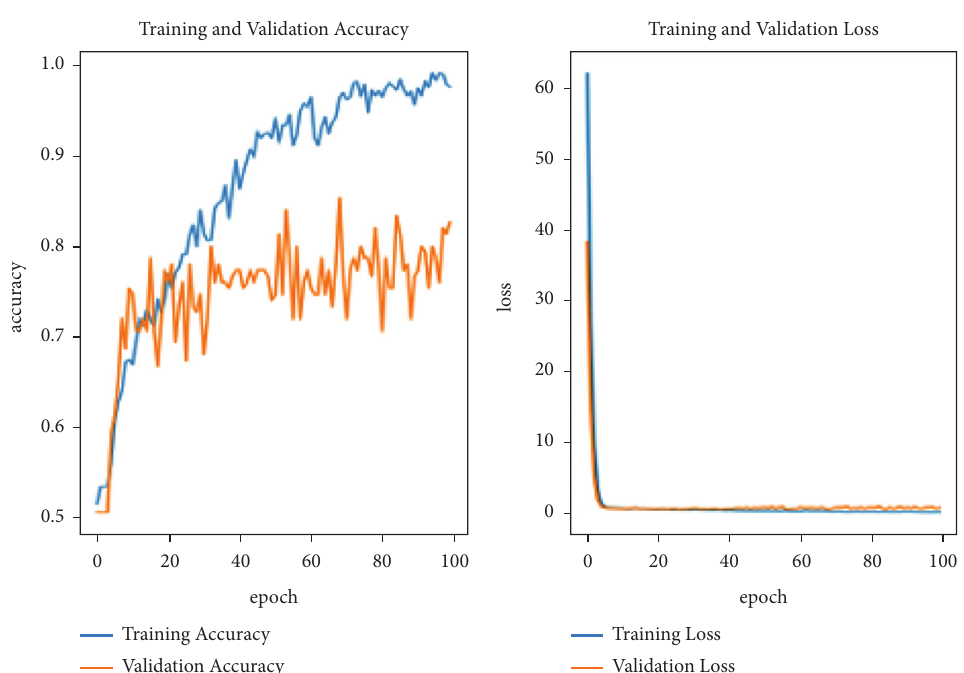
Figure 10: Accuracy and loss with AlexNet-based CNN model.